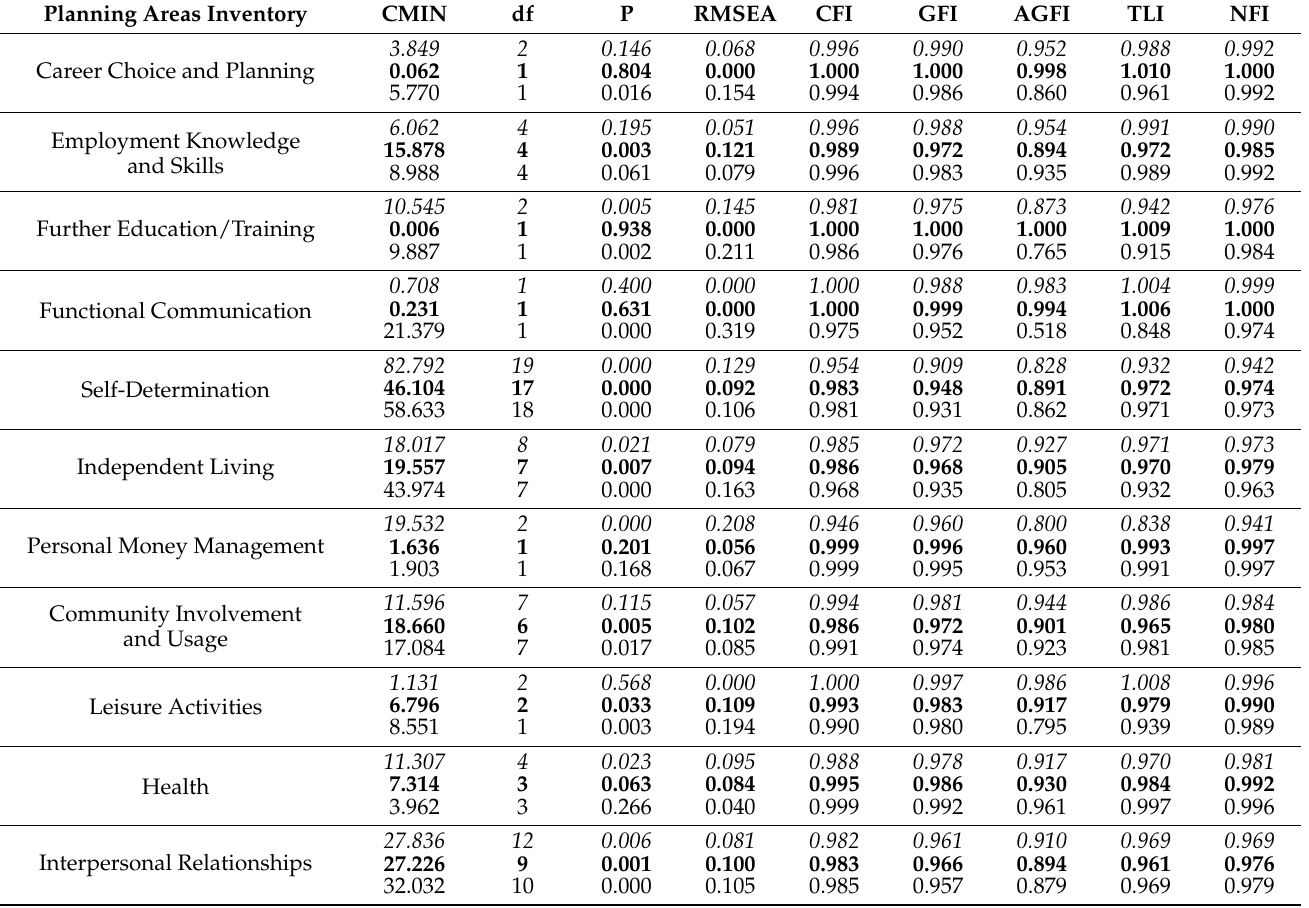
Table 3. Fit indices for all scales for Model